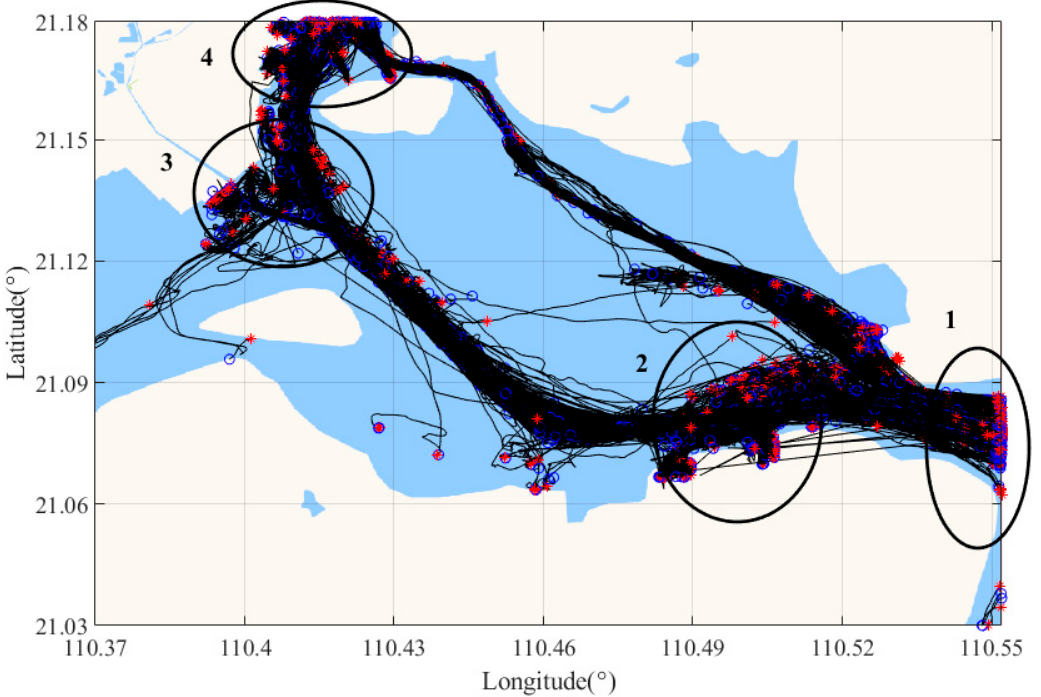
Figure 8. The original moving trajectories in Zhanjiang Port (The red ‘*’s represent departures, the blue ‘o’s represent destinations).